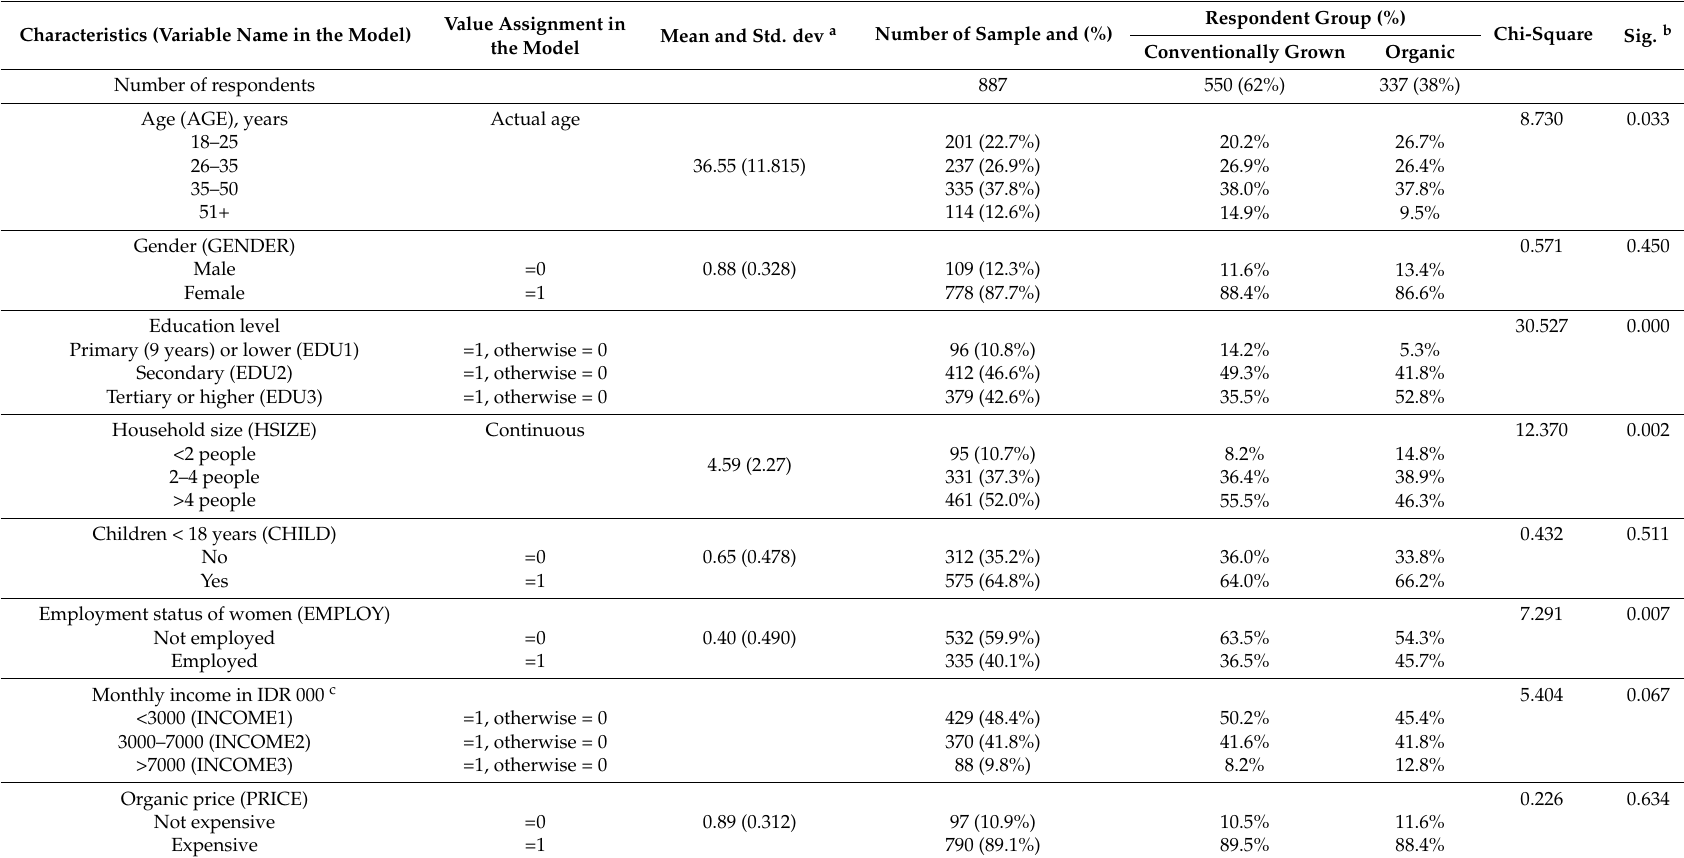
Table 2. Socio-demographic characteristics of the respondents and variable